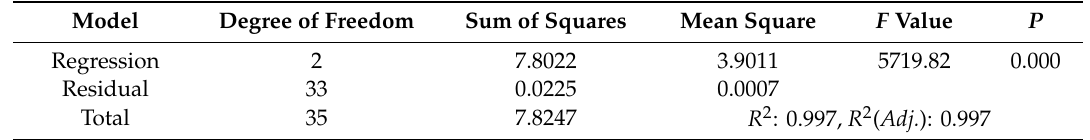
Table 6. ANOVA of the regression model for S q